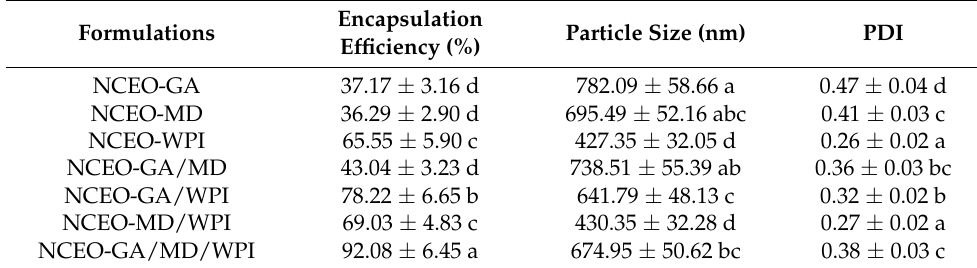
Table 3. Encapsulation efficiency, particle size, and polydispersity index (PDI) of CEO nanocapsules.